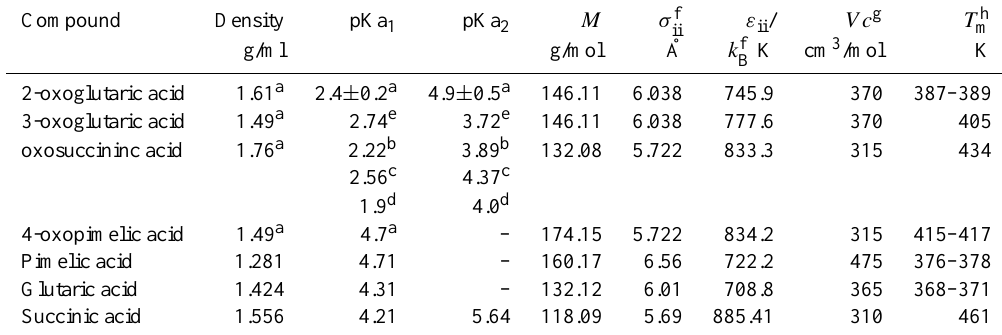
Table 1. Chemical and physical properties used in K¨ohler theory and evaporation analysis. Compound